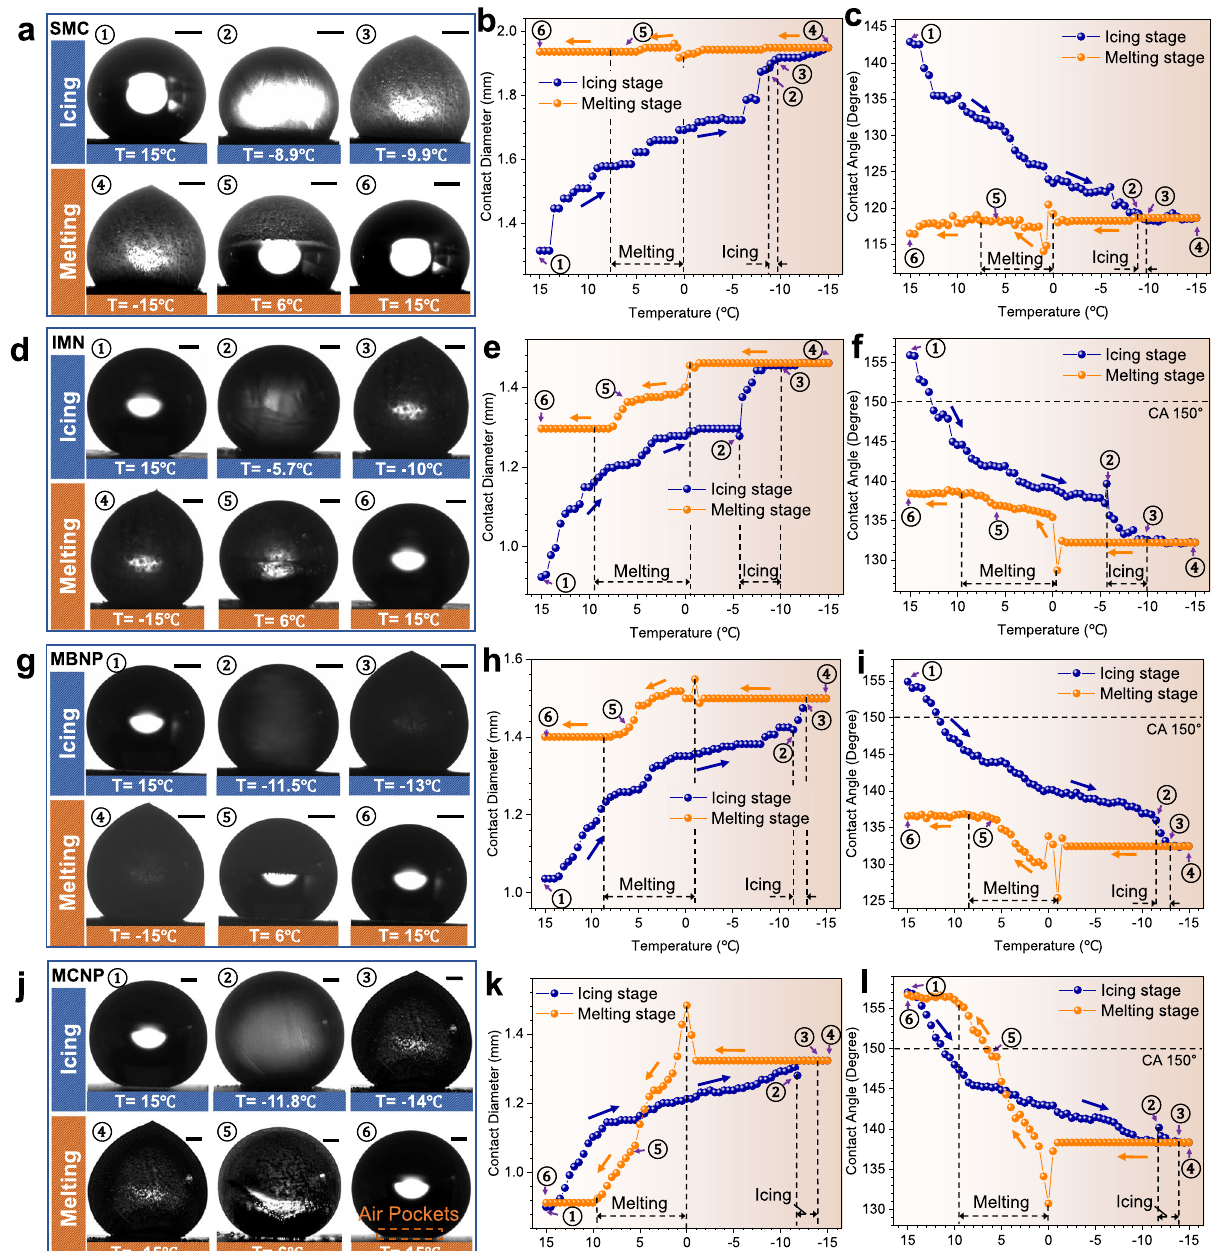
Fig. 2 States, contact diameters, and contact angles (CA) of droplets on the four hydrophobic surfaces during icing and melting processes. a – c On the SMC surface. d – f On the IMN surface. g – i On the MBNP surface. j – l On the MCNP surface. Orange dashed box marks the recovered air pockets in j . Blue represents the icing processes while orange denotes the melting processes. Black dashed lines mark icing zones and melting zones. Circulation directions are presented by blue arrows (icing direction) and orange arrows (melting direction). The CA 150° boundaries of superhydrophobicity are indicated with black dashed lines. Scale bars and temperatures corresponding to different states are marked. The scale bars of a , d , g and j are 500 μ m, 500 μ m, 500 μ m, and 300 μ m, respectively. The fl uctuations of the correlation evaluations can be found in the Methods